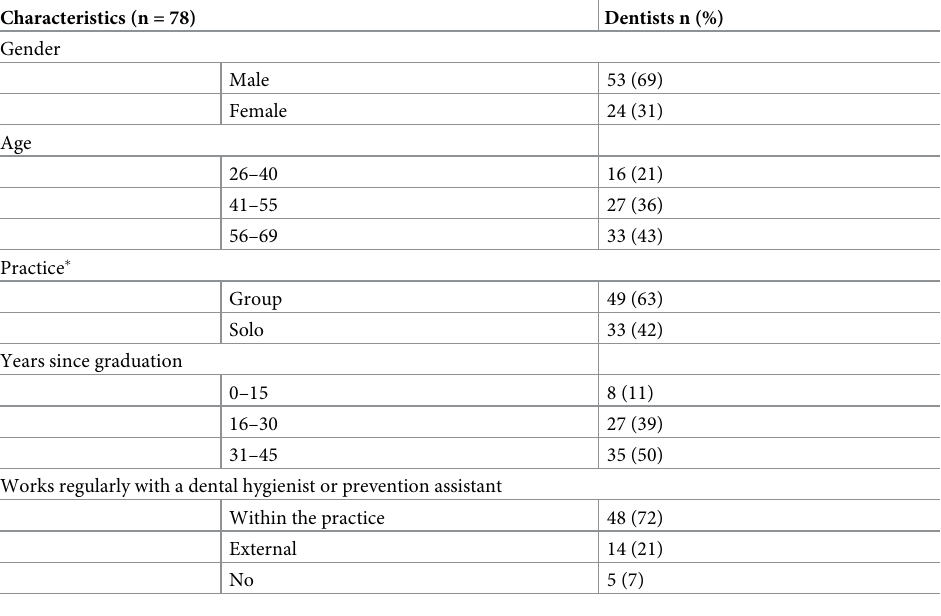
Table 1. Q-sample